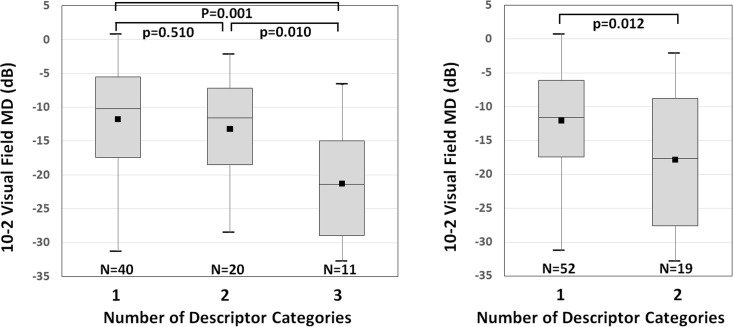
Box-and-whisker plots of 10–2 visual field mean deviation (MD) according to the number of descriptor categories per eye (a total of 71 eyes with Amsler grid scotomas).(Left) For 6 descriptor category classification in Table 1, and (Right) for 4 descriptor category classification in Table 1. The horizontal line within the box indicates the median, upper and lower boundaries of the box indicate the 75th and 25th percentiles, respectively, and the whiskers indicate the maximum and minimum values. The black squares in the boxes indicate the mean. Asterisks indicate p values <0.05.